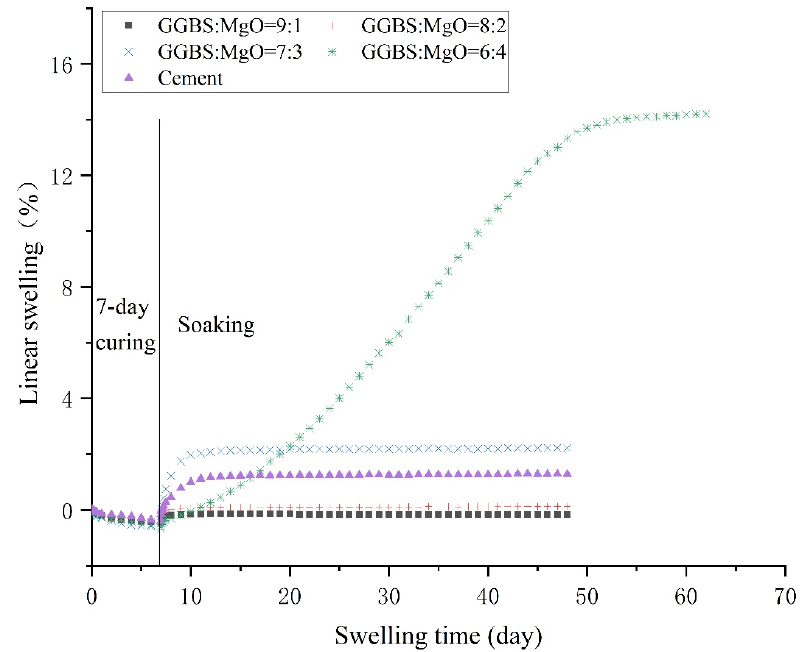
Figure 4. Vertical swelling percentages of Ca-sulfate-soil treated with cement and GGBS-MgO.